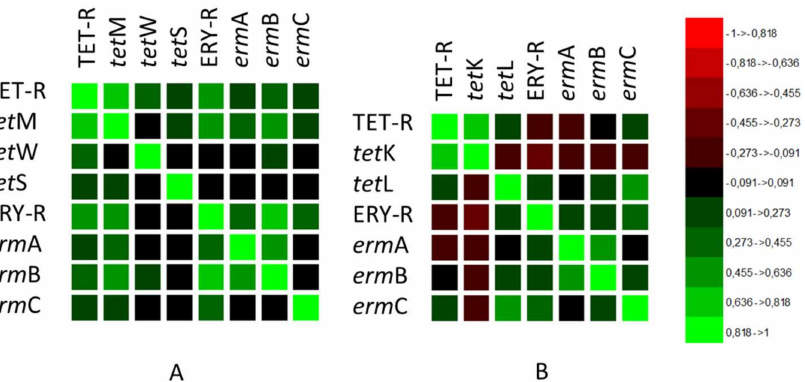
Figure 1. Correlation matrix of phenotypic and genotypic features regarding tetracycline and erythromycin antibiotic resistance in ( A ) LAB species and ( B ) CNS